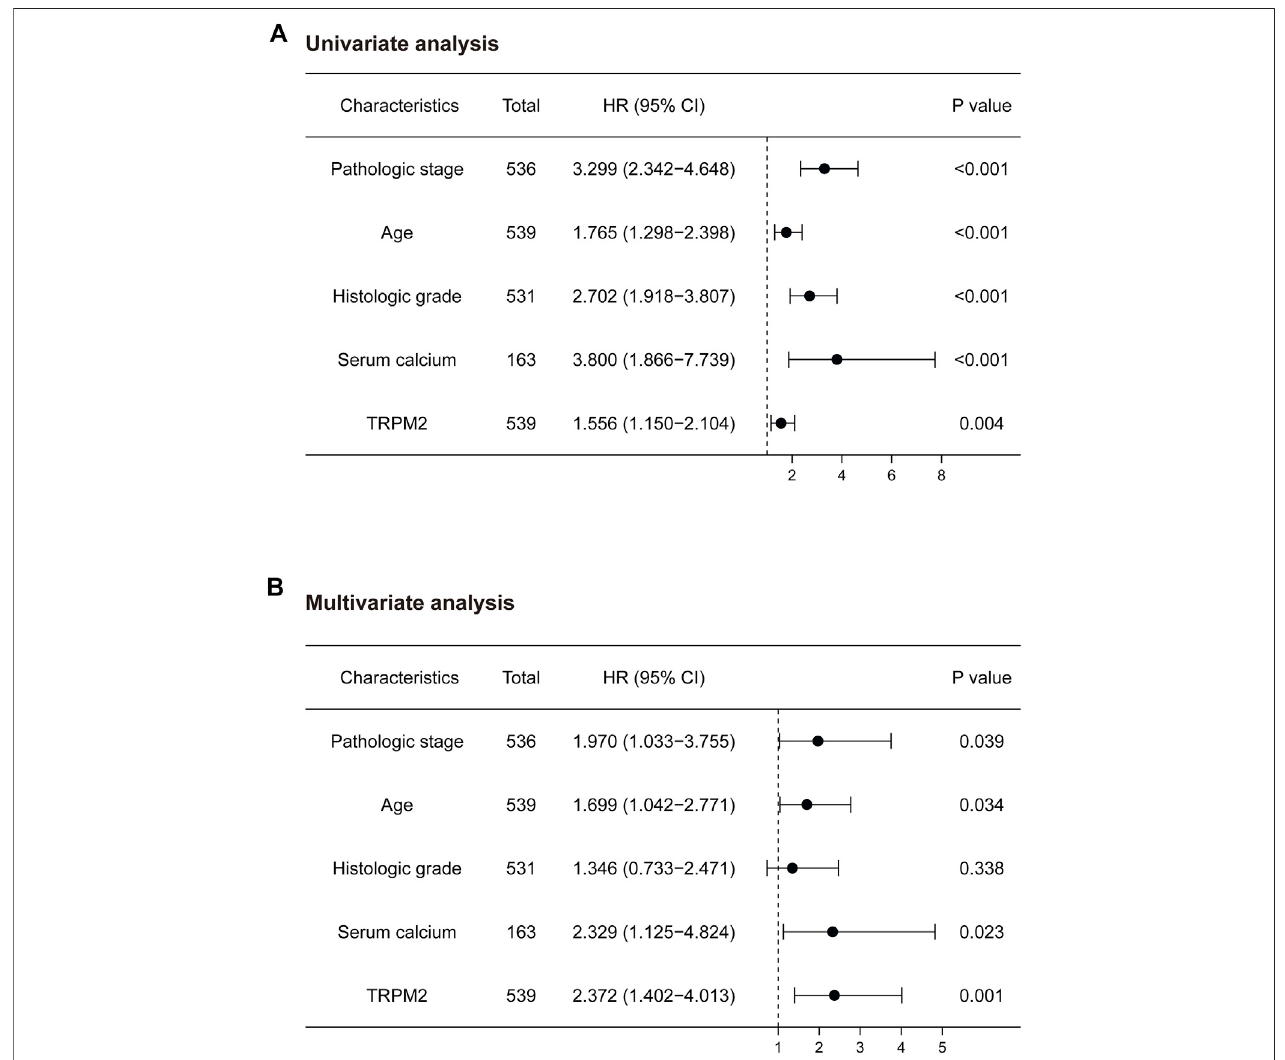
FIGURE4| Univariate and multivariate analyses ofthe factors associated withthe overallsurvival(OS)ofkidney renal clear cellcarcinoma(KIRC) patientsfrom The CancerGenomeAtlas(TCGA) database.Forestplotsdisplay theprognosticvaluesoffactorsassociatedwiththeOSofKIRCpatients.HRand p -valueswerecalculated using univariate (A) or multivariate (B) Cox proportional hazards regression. Blue circles represent the hazard ratio (HR).